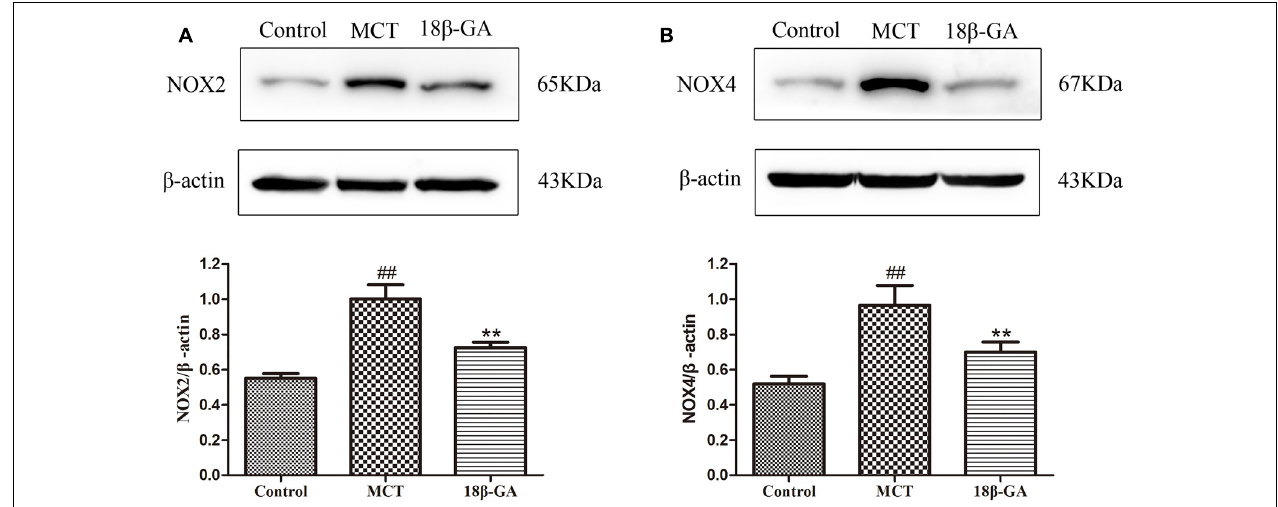
FIGURE 9 | Effects of 18 β -glycyrrhetinic acid on NOX-2 and NOX-4 expression. (A) Representative Western blot band of NOX-2 activation in the lung tissues. (B) Representative Western blot band of NOX-4 activation in the lung tissues. Data are expressed as mean ± SEM ( n = 10). ## p < 0.01 vs. control group, ∗ p < 0.05, ∗∗ p < 0.01 vs. MCT group. NOX-2, nicotinamide adenine dinucleotide phosphate (NADPH) oxidase-2; NOX-4, nicotinamide adenine dinucleotide phosphate (NADPH) oxidase-4; MCT, monocrotaline; GA, 18 β -glycyrrhetinic